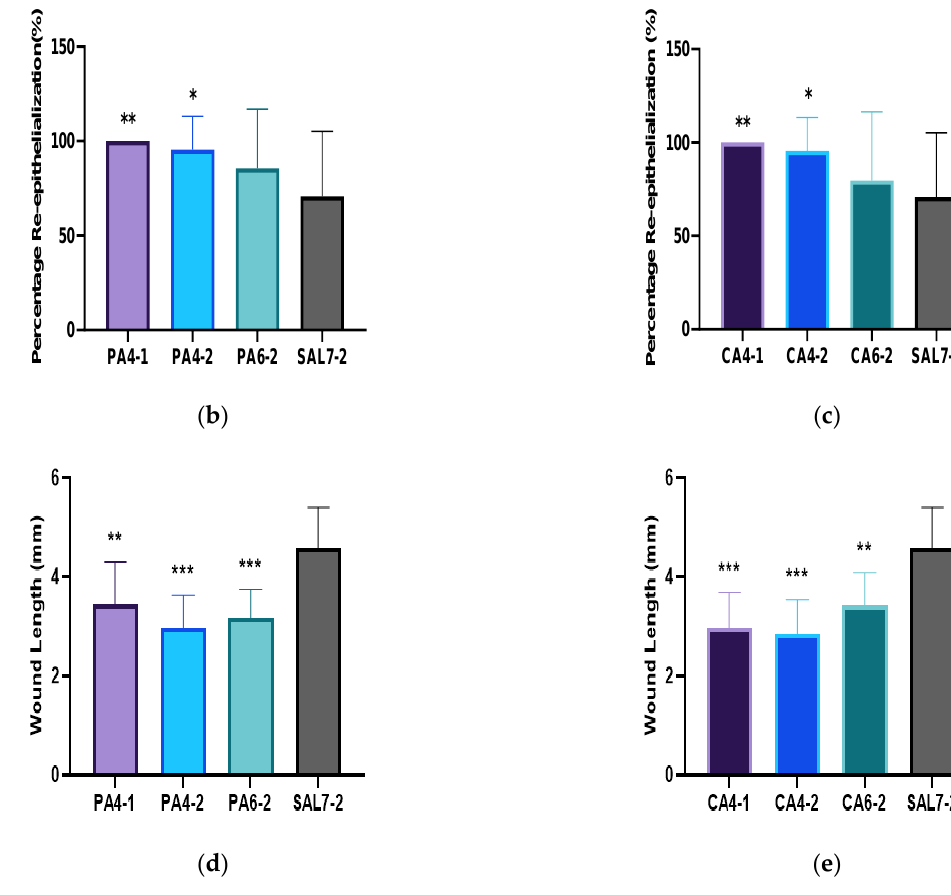
Figure 2. Microscopic analysis confirmed by hematoxylin and eosin (H&E) staining of percentage wound recovery after one week of topical administration of phosphoric acid (PA) and citric acid (CA) buffered solutions with different pH values and treatment regimes. ( a ) Full-thickness punch biopsy sample obtained from animal model in all acidic buffered treatment groups and saline control group at Day 7 post-injury. Original magnification 4×. Black scale bar represents 500 µm. Black arrows indicate the width of new tissue formation, blue dotted line indicate the re-epithelialized area, red dotted line indicate the panniculus gap measurement, and black dotted line indicate the base of epithelium. ( b ) Percentage re-epithelialization of animal model following topical treatment with phosphoric acid buffer solutions of pH 4 and pH 6. ( c ) Topical administration of citric acid buffer solutions or saline as control group. ( d ) Measurement of wound length at Day 7 post-injury following topical treatment with phosphoric acid buffer solutions of pH 4 and pH 6. ( e ) Wound length obtained from animal model after topically treated with citric acid buffer solutions with pH adjusted to 4 and 6 for 7 days. Each bar represents mean ± standard deviation. * p < 0.05, ** p <0.01 and *** p < 0.001 indicates the results obtained were statistically significant from control group (SAL7-2).